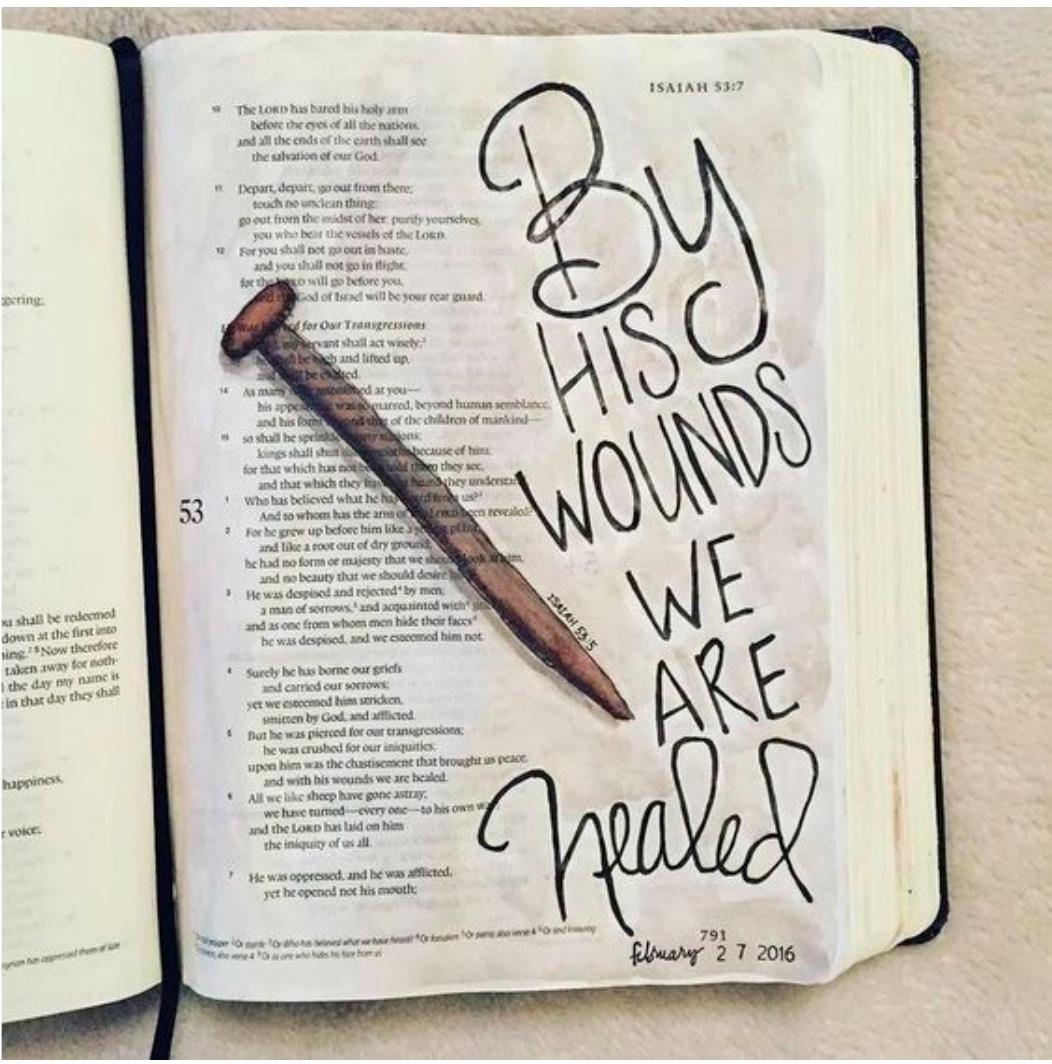
Figure 1. “Isaiah 53.5, By His Wounds We Are Healed” (2016) by Brittany Cowley (with kind permission of the